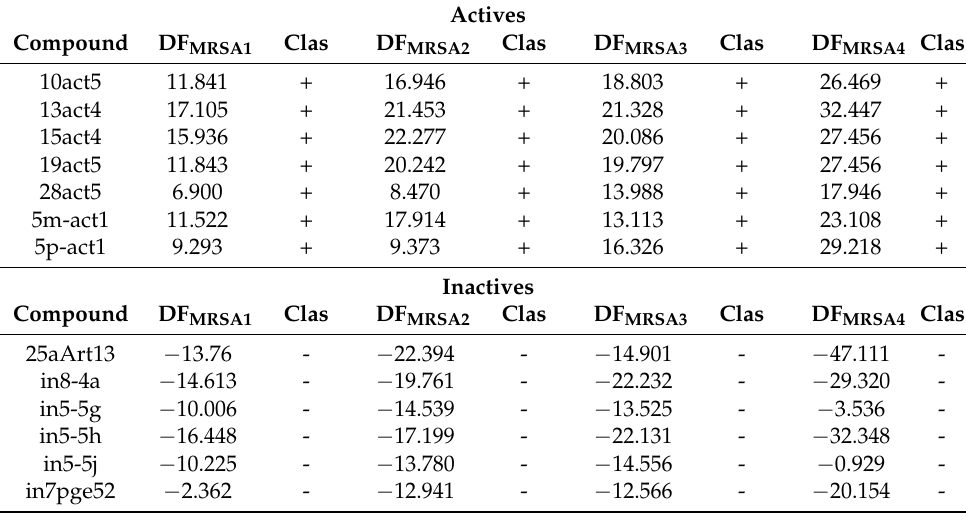
Table 7. Results obtained after combining LDA and PDD for DF1–4. Test